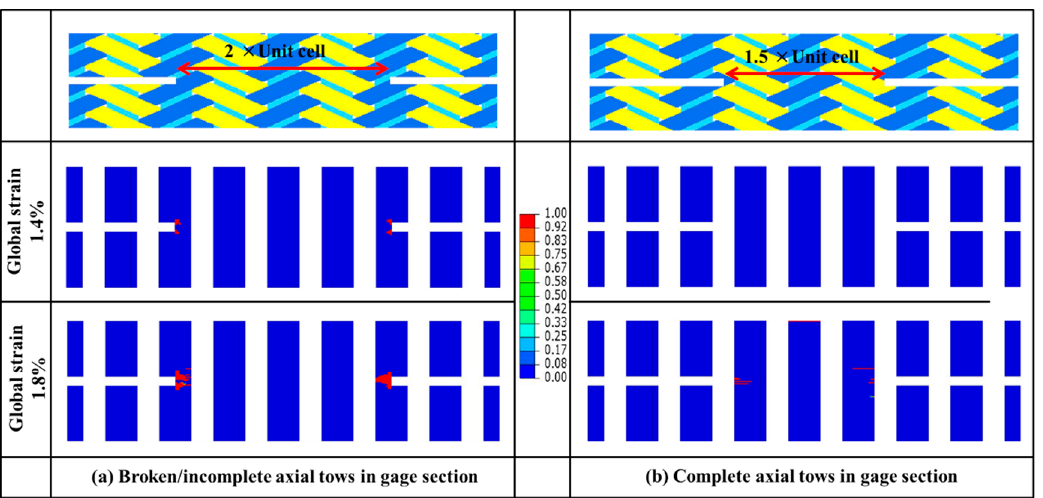
Figure 11. Comparison of predicted damage in in-complete ( a ) and complete ( b ) axial fiber bundles in gauge region.